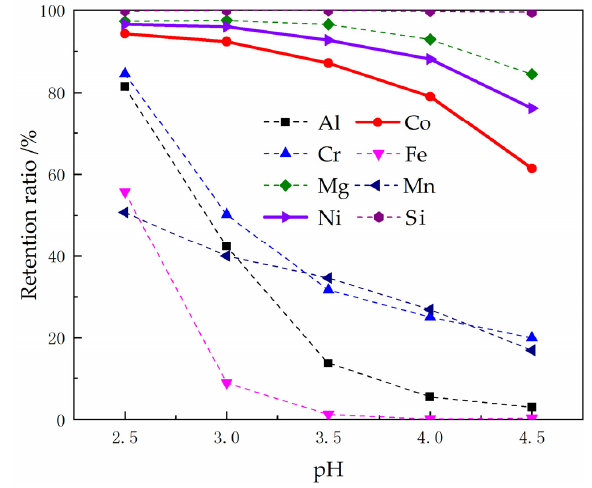
Figure 7. E ff ect of pH on precipitation of Figure 7. Effect of pH on precipitation of metals.